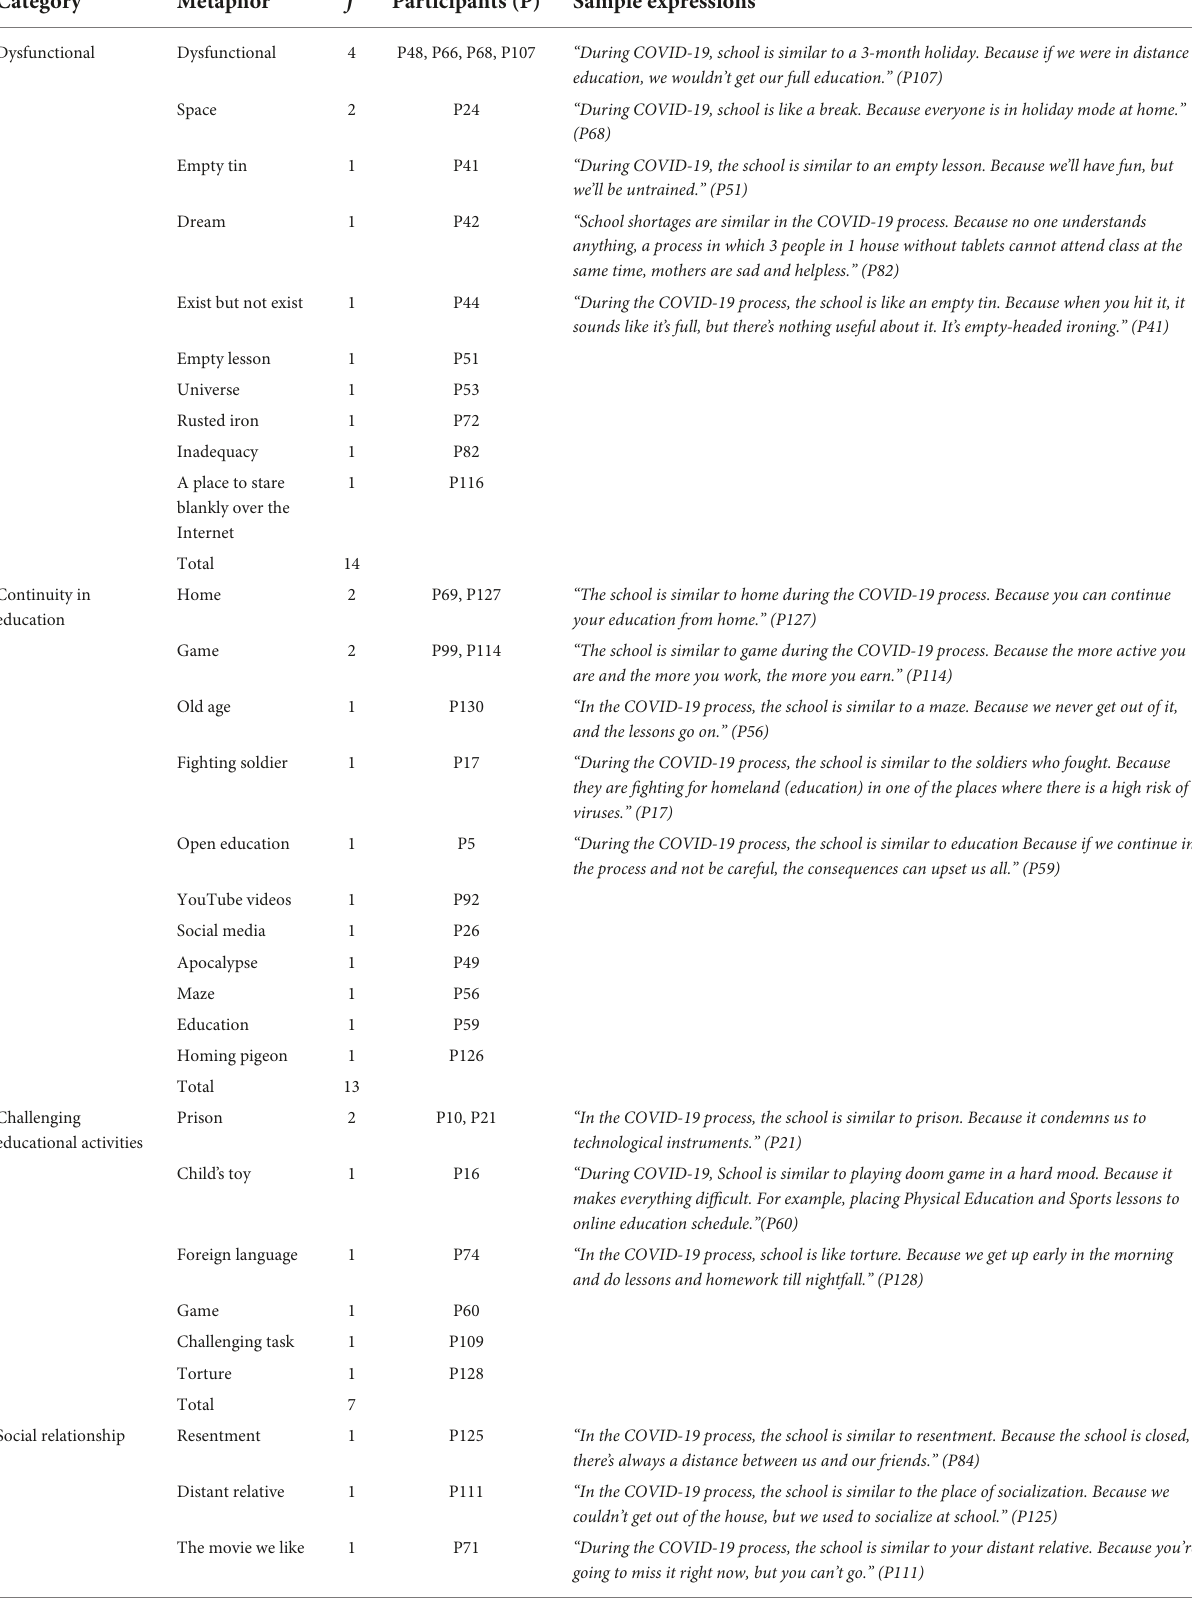
TABLE 15 Categories are dysfunctional, continuity in education, challenging educational activities, social relationship, and safe environment.